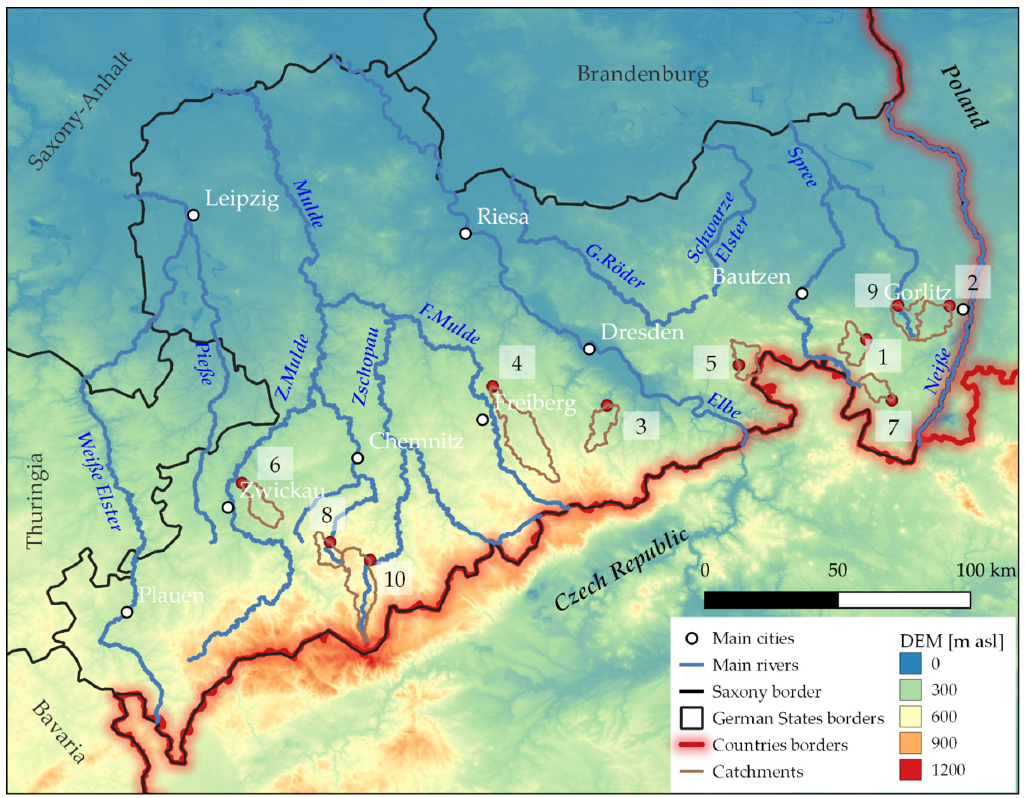
Figure 1. An overview of ten selected catchments for validation (WGS-84 Pseudo-Mercator projection) with a background from a digital elevation model (DEM) based on SRTM30. The ID numbers of the catchments can be referred to in Table 1.